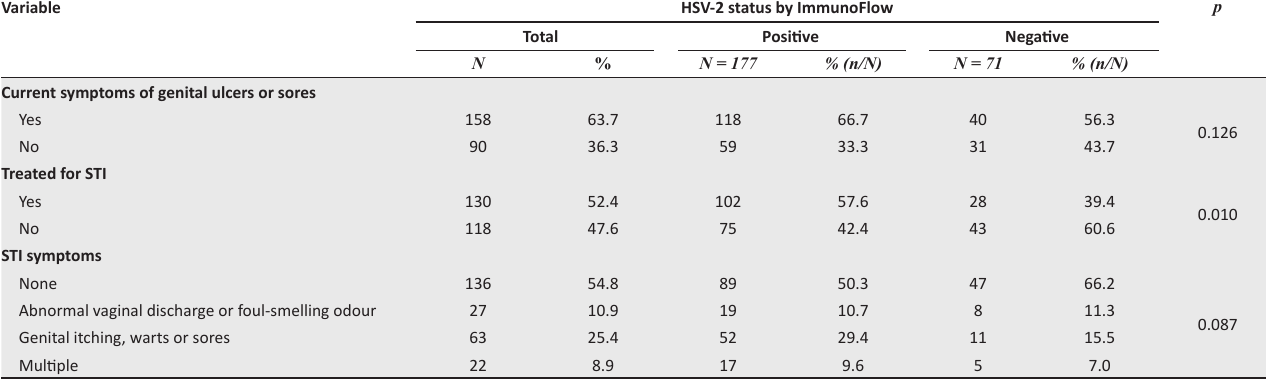
TABLE 1 (Continues...): Description of pregnant women recruited from the antenatal clinic of the King Edward VIII Hospital in Durban, KwaZulu-Natal, South Africa, 2017. Variable